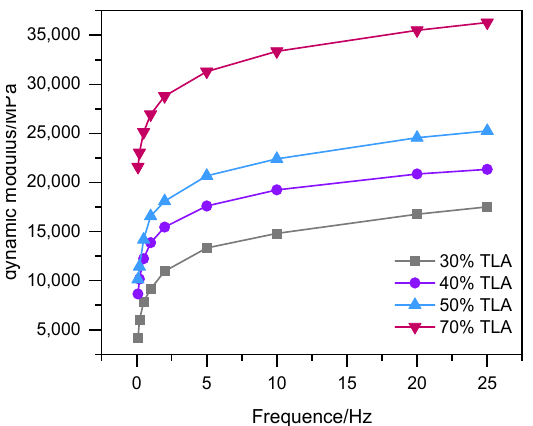
Figure 5. Test results of the EME-20 asphalt mixture containing 50% of RAP under 0–25